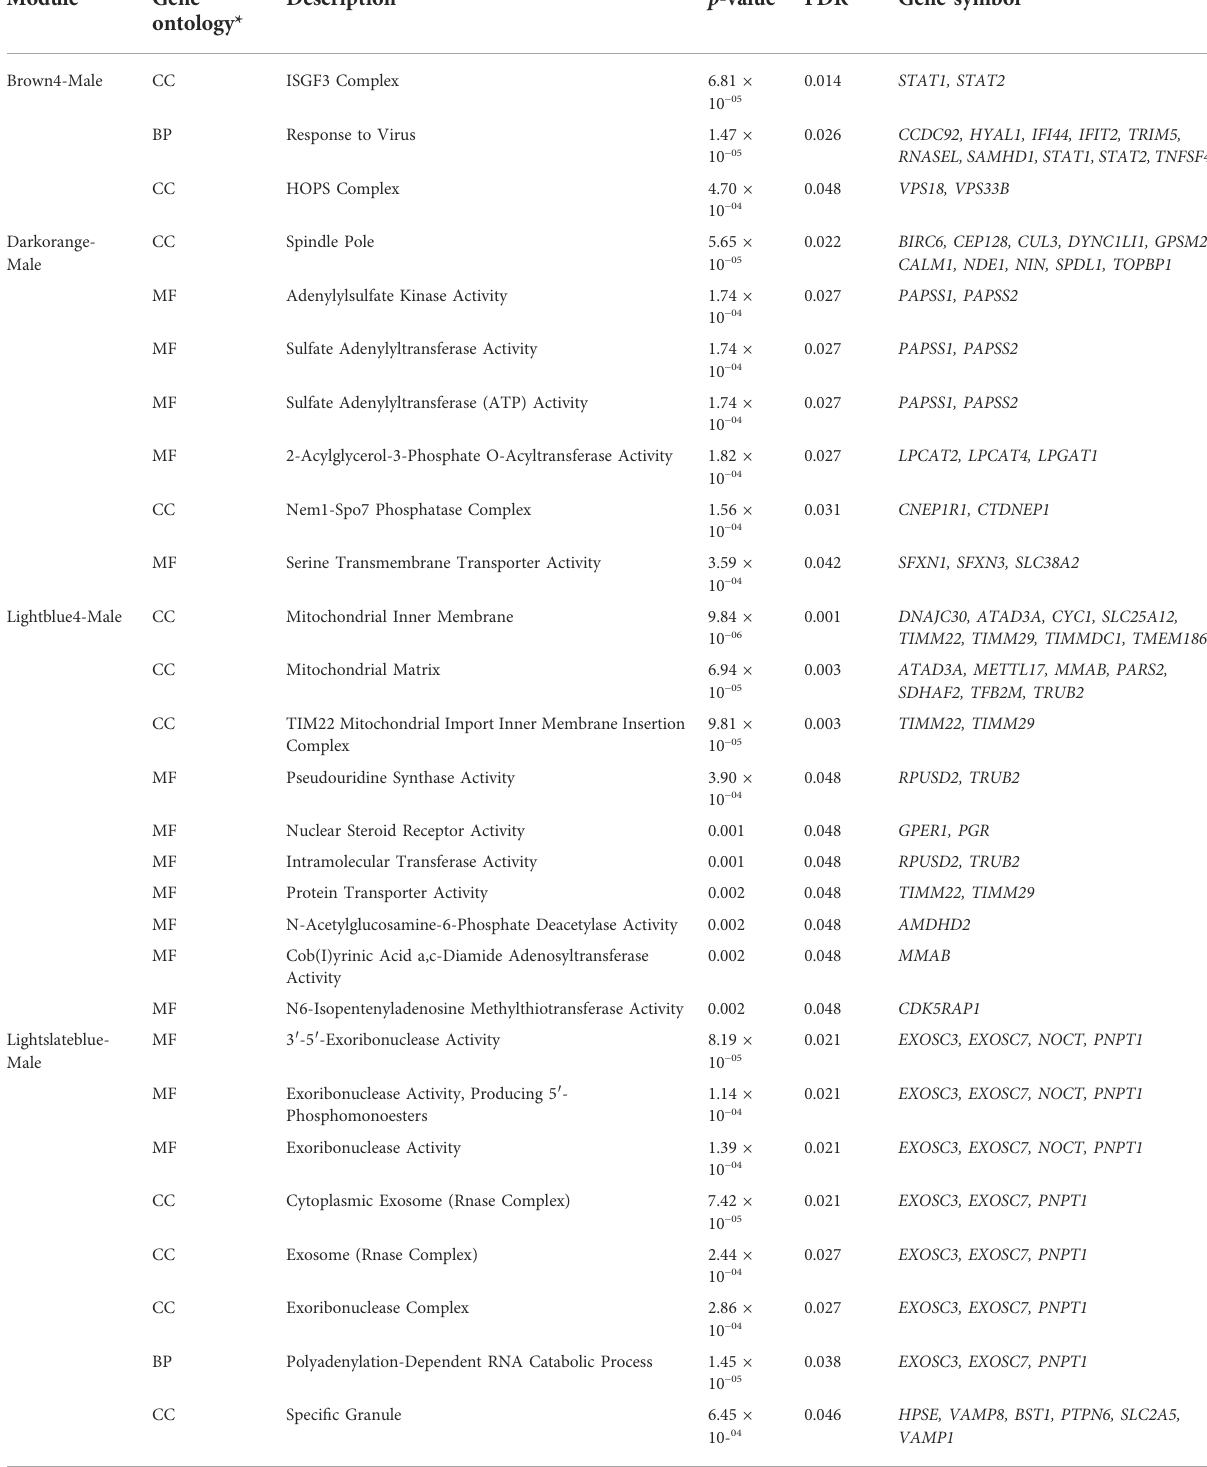
TABLE 4 Top ten enriched (FDR < 0.05) gene ontology terms (when available) for genes allocated within the differentially coexpressed modules between males and females Assaf suckling lambs correlated with the fat percentage in different fat deposits (Renal, Pelvic, Renal and Pelvic, Leg subcutaneous, and Leg intramuscular). For each module, the gene ontology process (see table footnote), its speci fi c description, the nominal p -value, the adjusted FDR p -value, and the genes involved in the GO term are